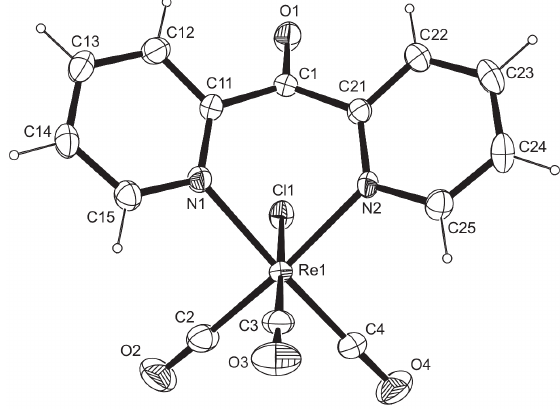
Table 2: Atomic coordinates and displacement parameters (in Å 2